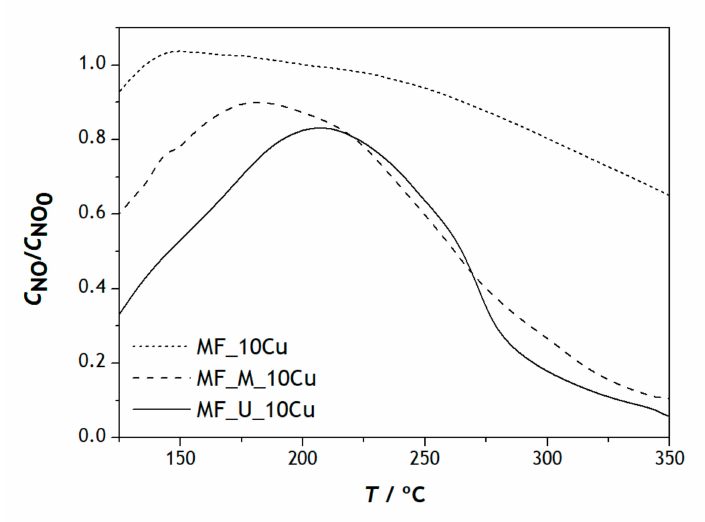
Figure 6. NO concentration in the presence of MF with [NO] = 1000 ppm in He with 5% of O 2 . Table 3. NO conversions obtained at 350 ◦ C in the presence of